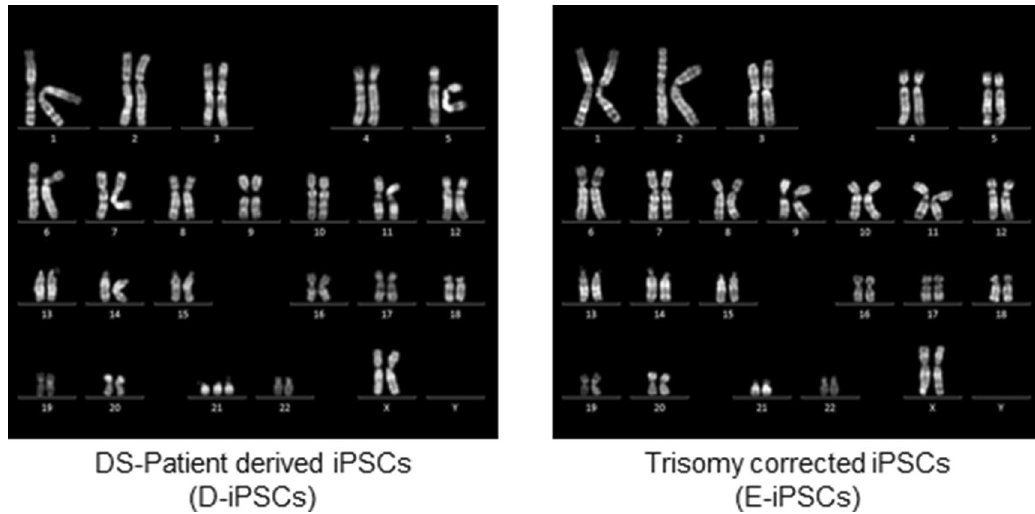
Figure 1. Karyotype analysis of the iPSC